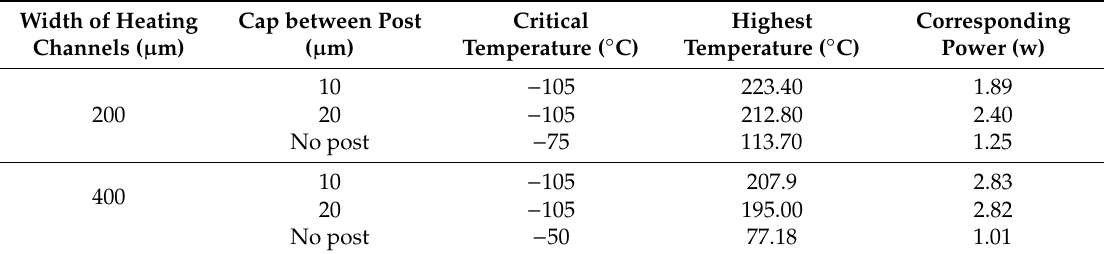
Table 2. Comparison between microheaters with and without parallel ventilating side-channels. Width of Heating Channels ( µ m)